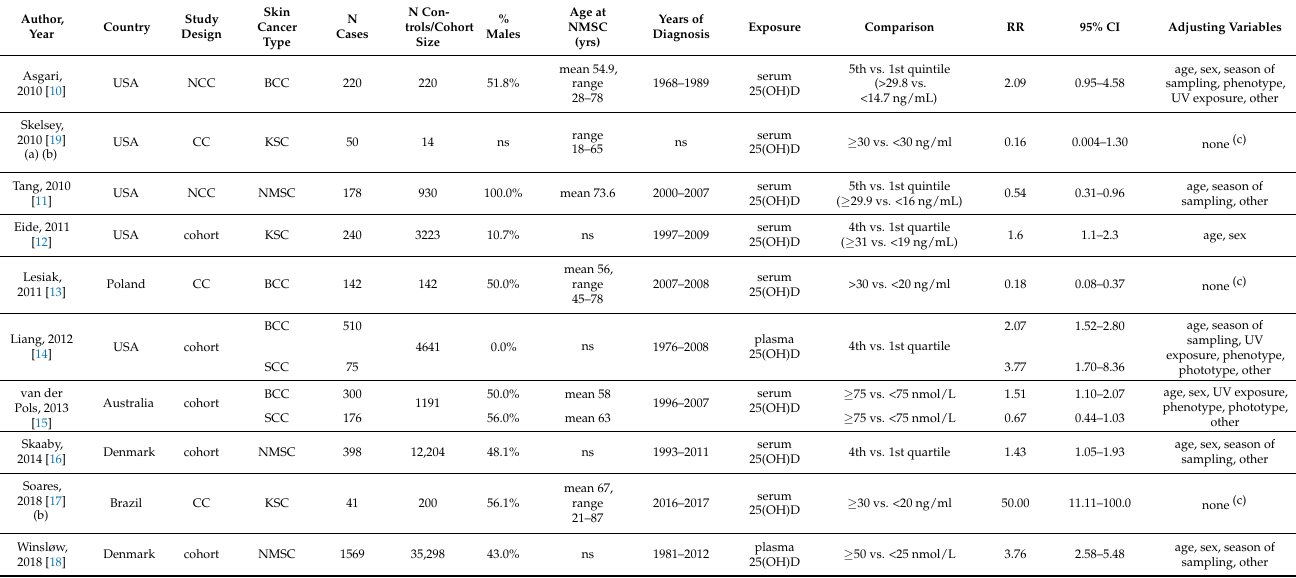
Table 1. Main characteristics of the studies reporting on the association between serum/plasma concentration of 25(OH)D (comparison: highest vs. lowest category) and the risk of non-melanoma skin cancer.